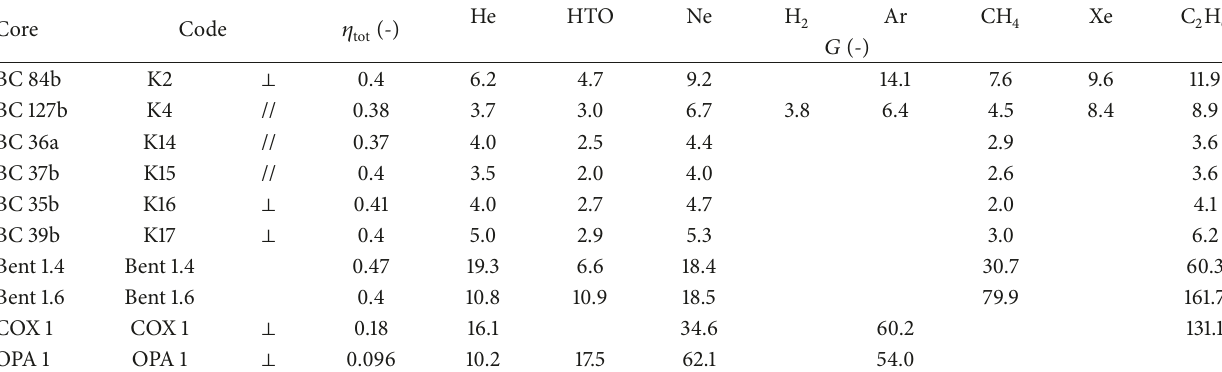
Table 5: Geometrical factors obtained from the aqueous and effective diffusion coefficients from Table 4. Note that similar to the previous table, the reference value of 0.18 is used for the COX1 total porosity. Core